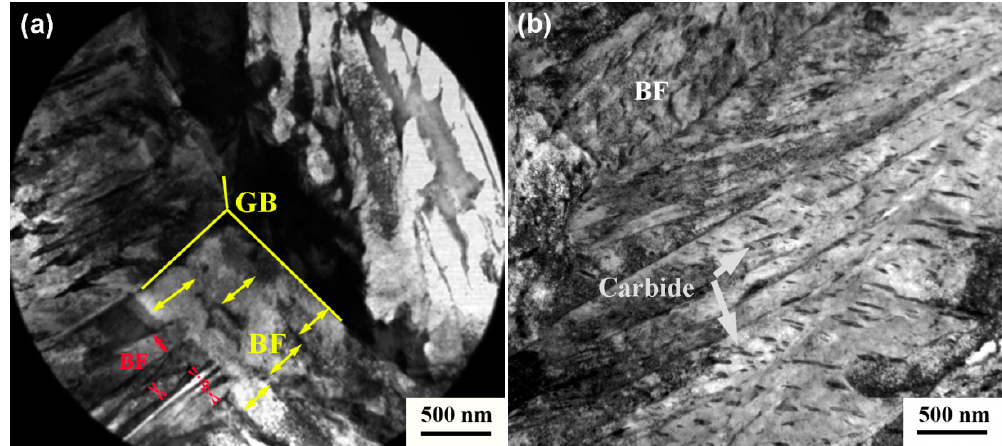
Figure 6. TEM micrographs of the tested steels: ( a ) carbide-free bainite; ( b ) carbide-bearing bainite.